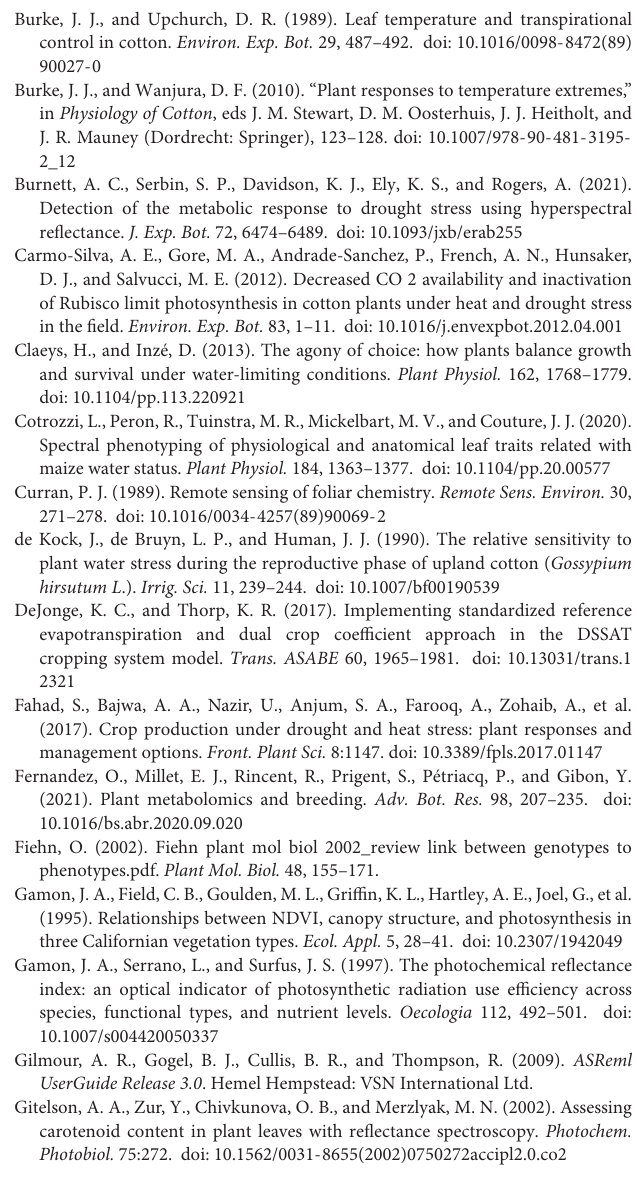
hyperspectral data, and vegetation